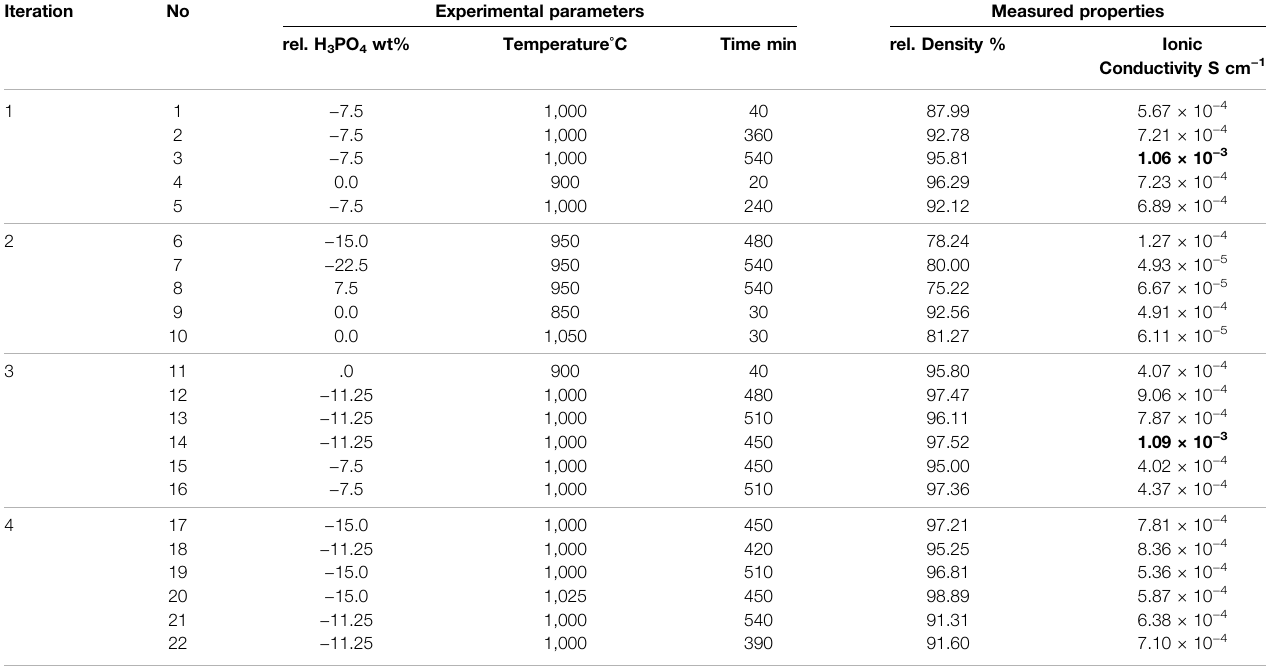
TABLE 2 | Recommended samples using BO and measured properties.